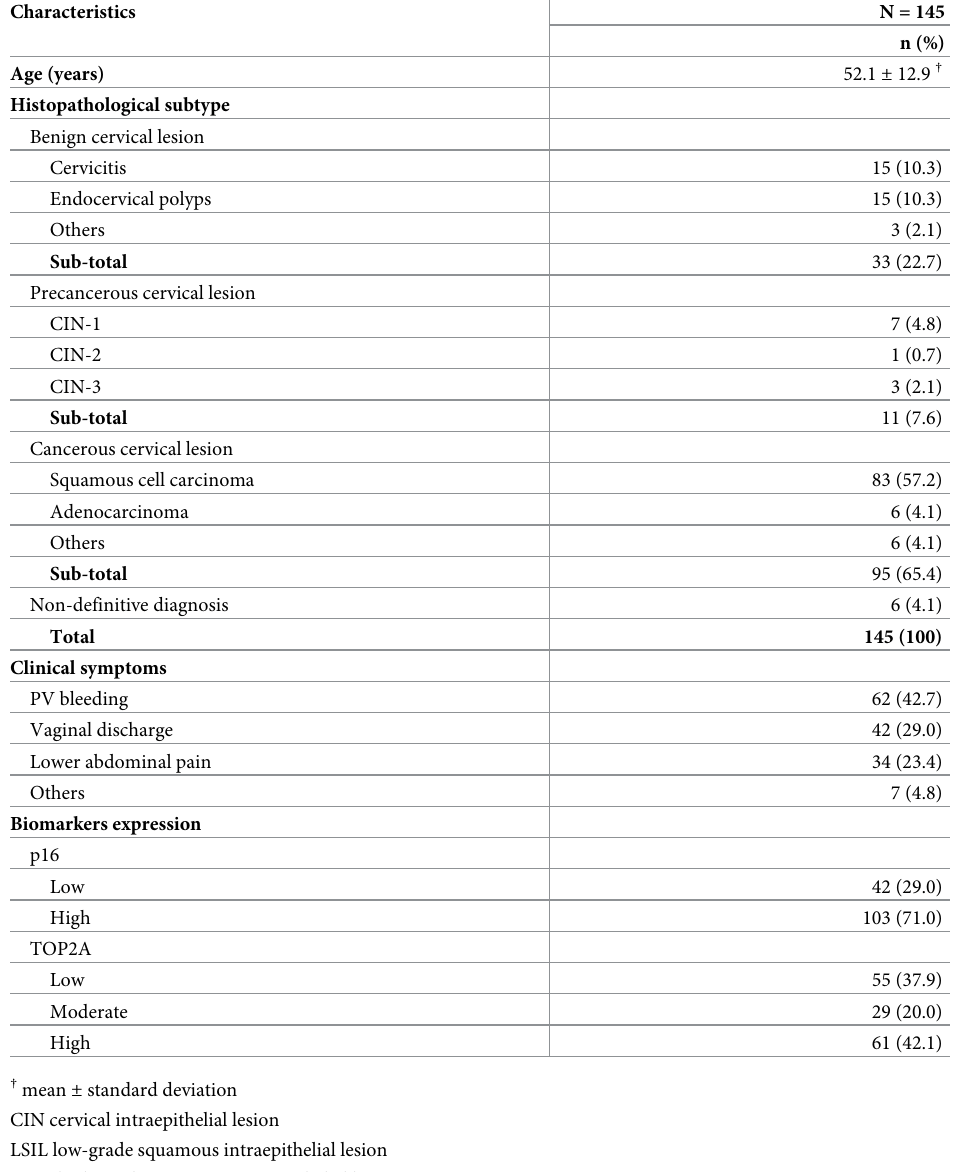
Table 1. Clinico-histopathological features among women seeking cervical cancer care at Kilimanjaro Christian Medical Centre (n = 145).